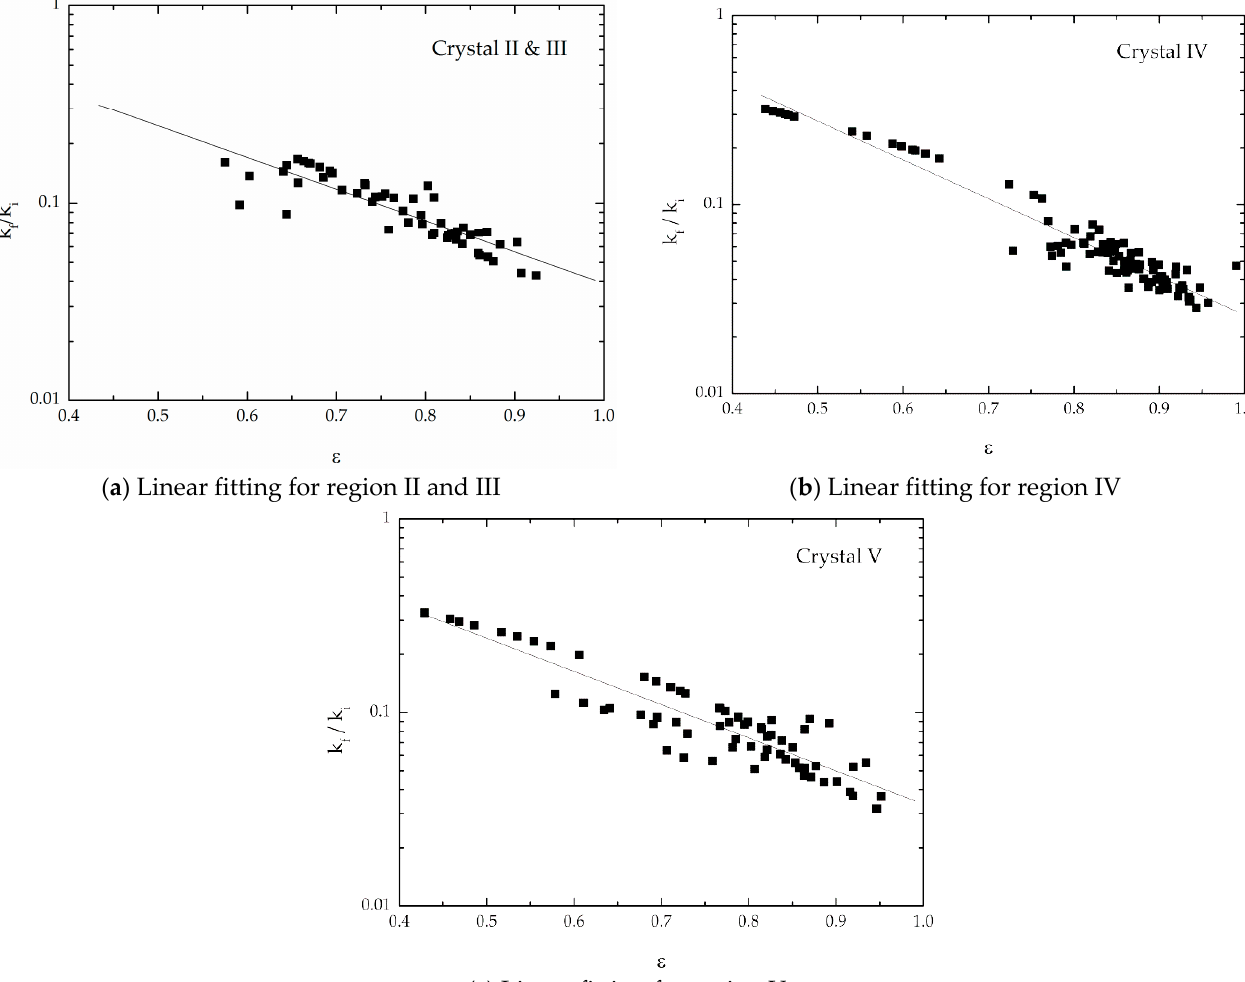
Figure 3. Best fitting based on the form of Equation (13) with different crystal shapes. Table 1. The fitting coefficients of Equation (13) and crystal shape for each region.